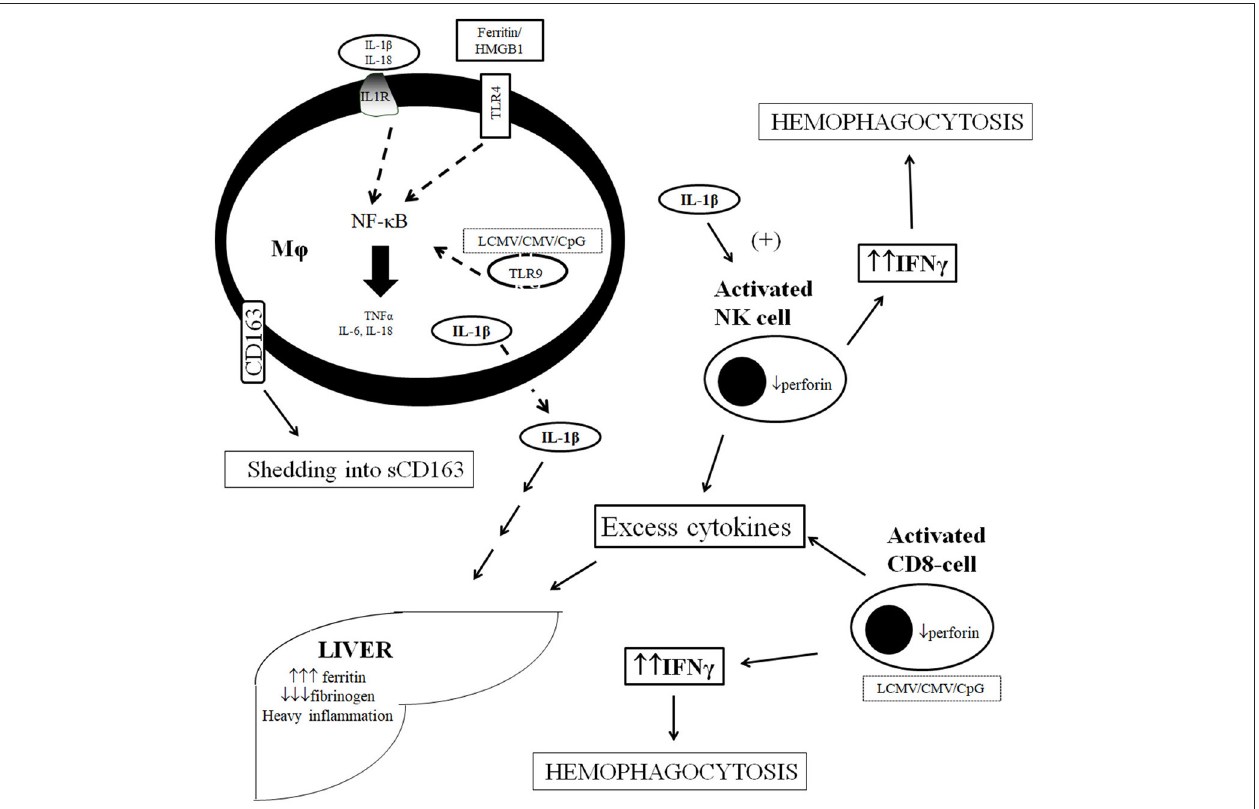
FIGURE 1 | Current concept of pathogenesis of macrophage activation syndrome in sepsis. Over-production of IL-1 β is effected through the stimulation of TLRs by ferritin and HMGB1 and by the per se autocrine effect of IL-1 β on IL-1R at the macrophage level. Stimulation leads to cytokine storm and shedding of CD163 from macrophage cell membrane. Over-produced cytokines stimulate further ferritin production by the liver and liver dysfunction whereas IL-1 β leads to over-production of IFN γ by NK cells leading to hemophagocytosis. Excess cytokine production may results independently by distirbances in NK cell and CD-cell function leading to their over-activation. CMV, cytomegalovirus; CpG, bacterial oligonucleotides; IL, interleukin; IL-1R, receptor of IL-1; LCMV, lymphocytic choriomeningovirus; M φ , macrophage, NF- κ B, nuclear factor kappa B; NK, natural killer; TLR, Toll-like receptor; TNF α , tumor necrosis